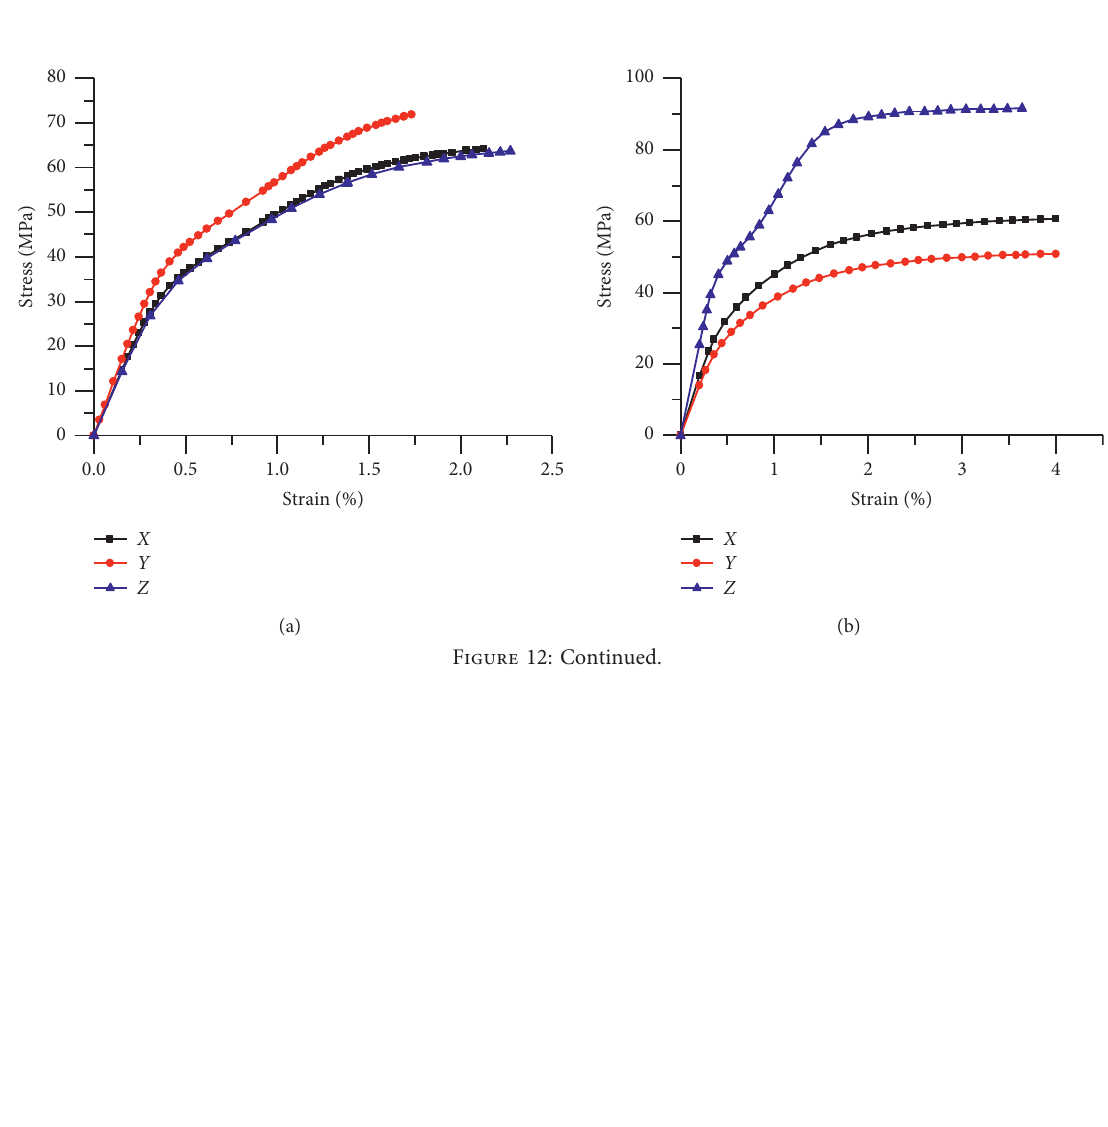
Figure 11: Cross-sections plastic strain distribution of model S2: (a) spatial location of slices at (b) y � 1mm, (c) y � 0.8mm, (d) y � 0.6mm, (e) y � 0.4mm, and (f) y �